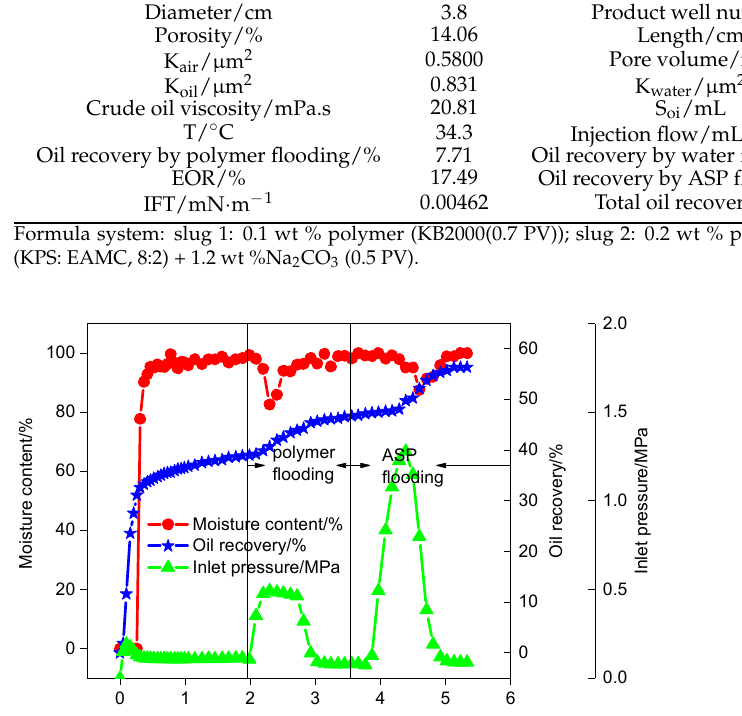
Table 4. Experiment of ASP flooding after polymer flooding.